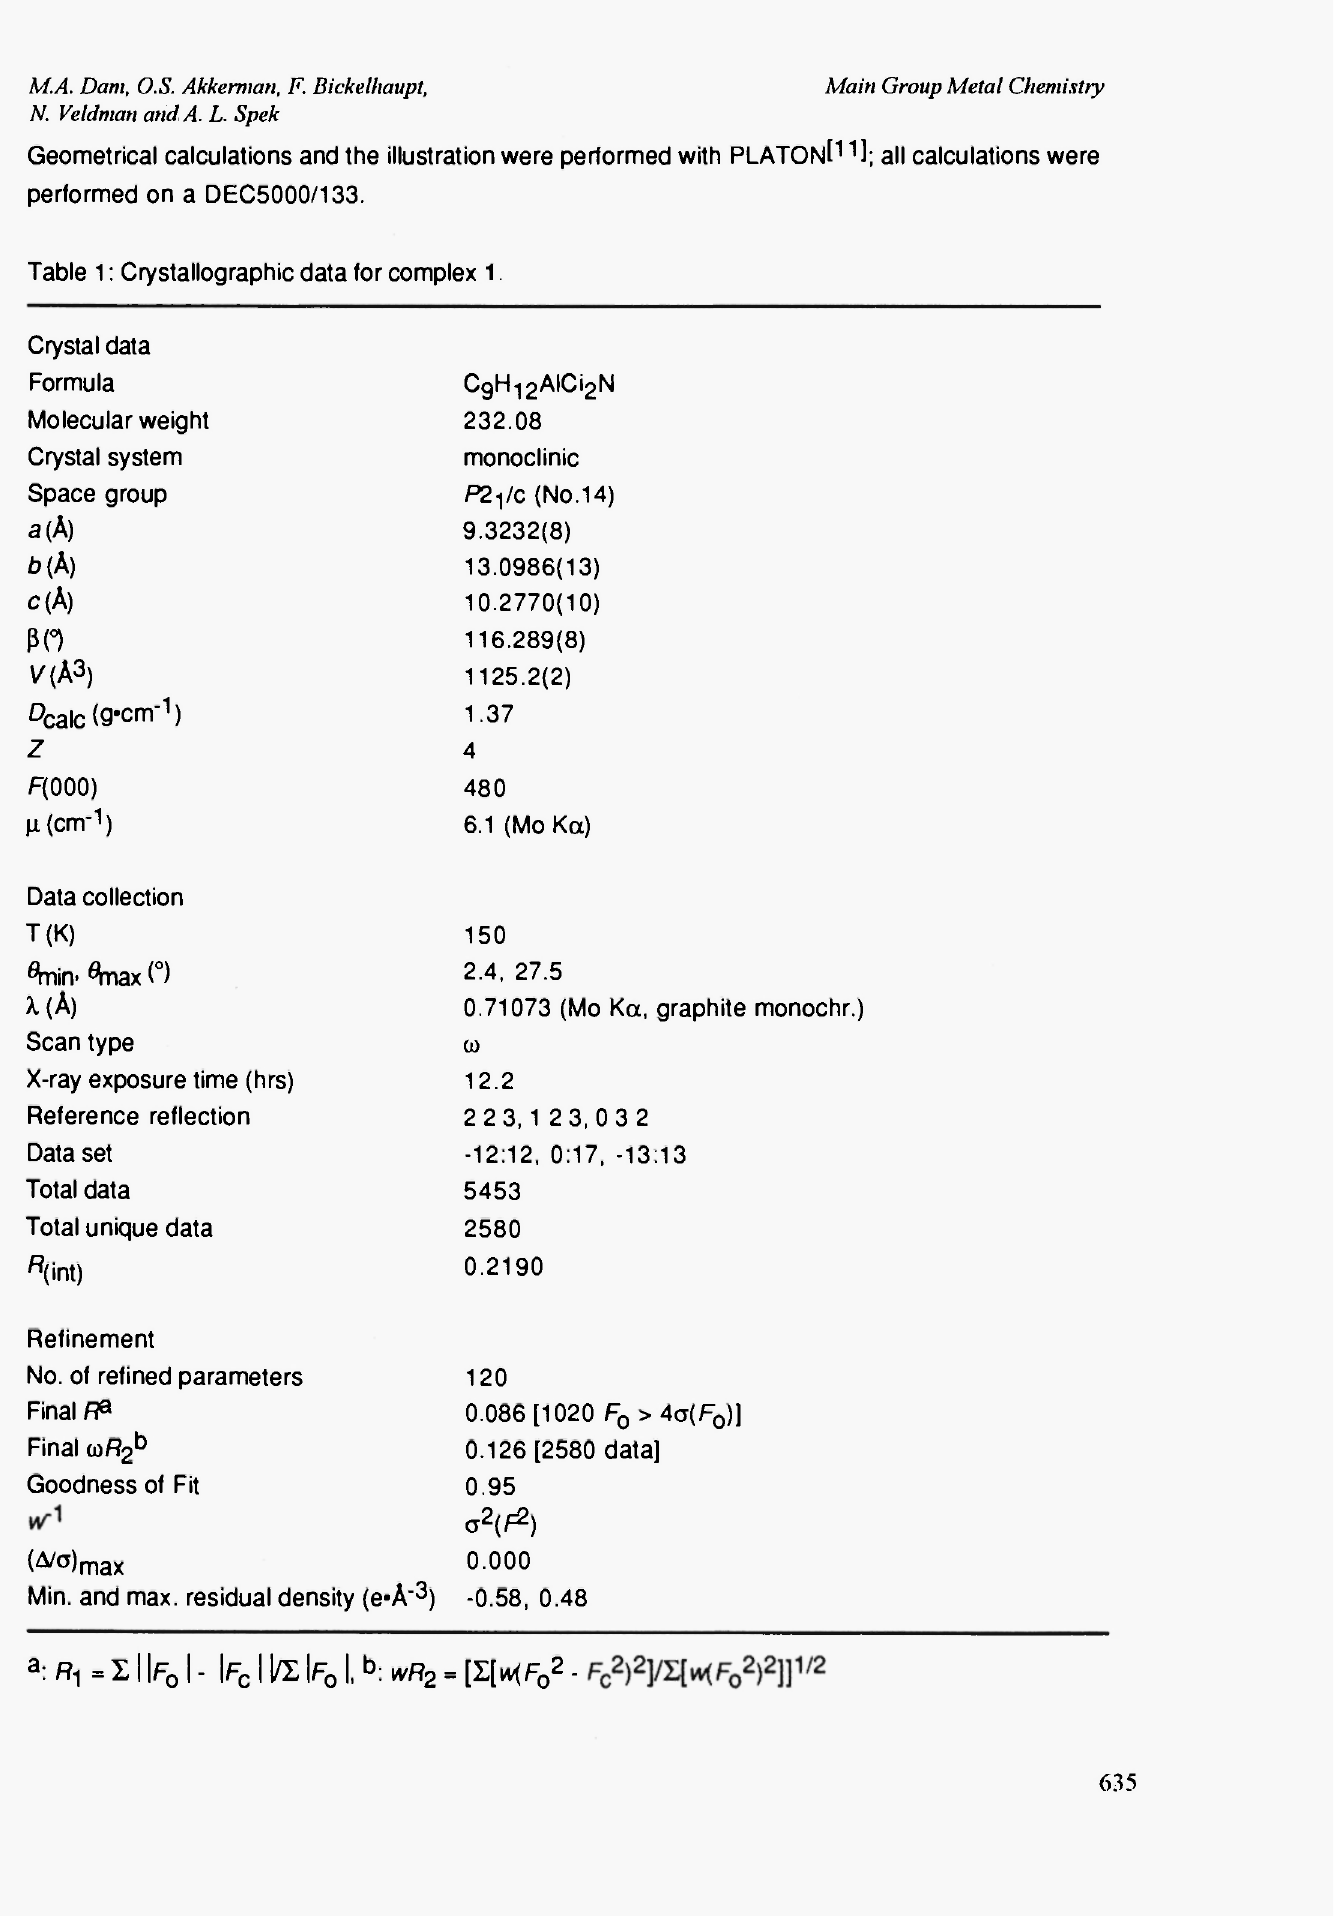
Table 1: Crystallographic data for complex